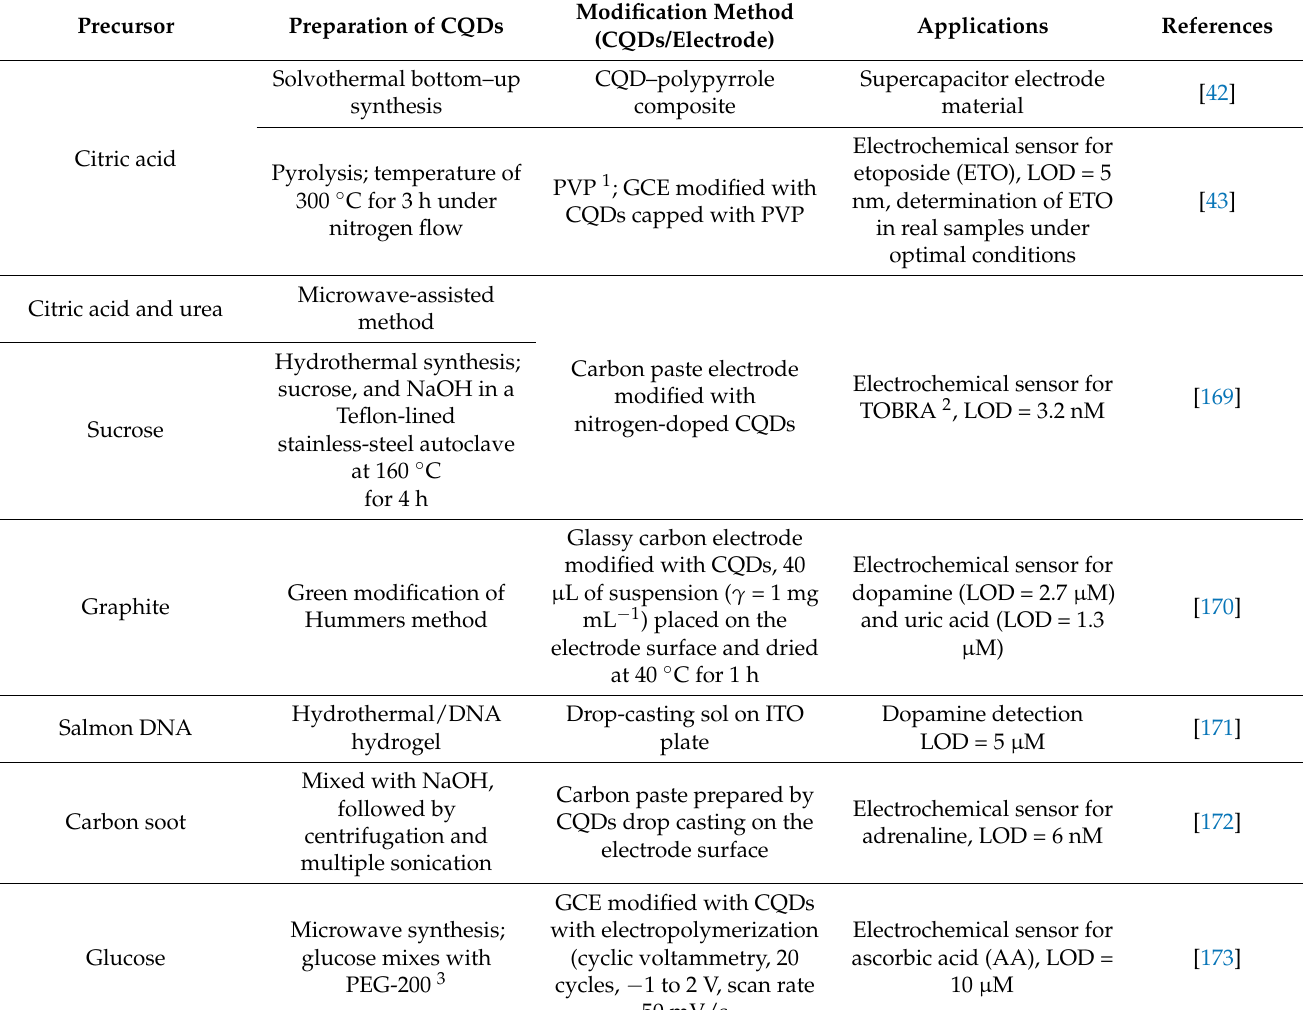
Table 8. Selected CQDs for the applications in electrochemical